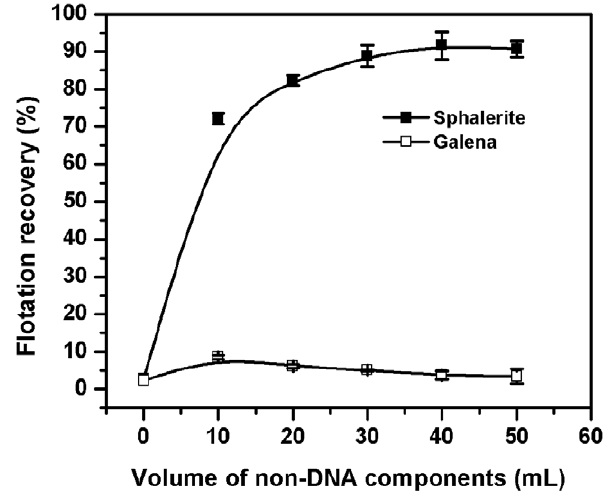
Figure 7. Flotation recovery of sphalerite and galena during reconstitution of the selective flotation of sphalerite with a fixed amount (2 mg) of ssDNA and varying amounts of DNase 1 treated non-DNA components of cells.